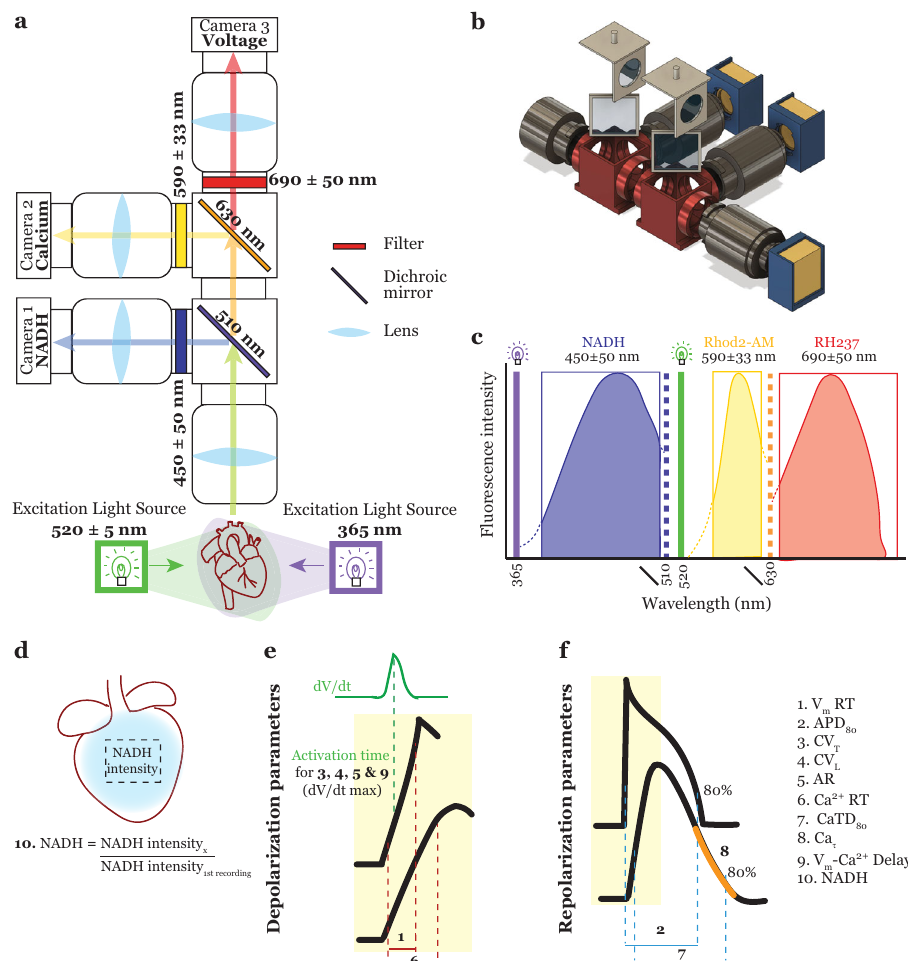
Fig. 1 Triple-parametric optical mapping system. a Schematic of the triple-parametric optical mapping system illustrating the optics used in the system and the light path for the three signals — V m , Ca 2 + , and NADH. b 3D rendering of the triple parameter optical mapping system illustrating the 3D printed hardware that houses the optics used in the system. c Spectra of the three parameter signals — NADH auto fl uorescence, Rhod2-AM (Ca 2 + ), and RH237 (V m ) fl uorescence, illustrating the separation of the three signals as implemented in this system. Solid vertical lines: LED light source wavelength, dotted vertical lines: dichroic mirror, boxes: fi lters. Illustration of the different parameters measured using the three optical signals. d NADH intensity was determined and each intensity value from a given heart was normalized to the NADH intensity from the fi rst recording from that heart. e De fi nition of parameters measured from the depolarization phase of the V m signal or the calcium release phase of the Ca 2 + signal. f De fi nition of the parameters measured from the repolarization phase of the V m signal or the calcium reuptake phase of the Ca 2 +